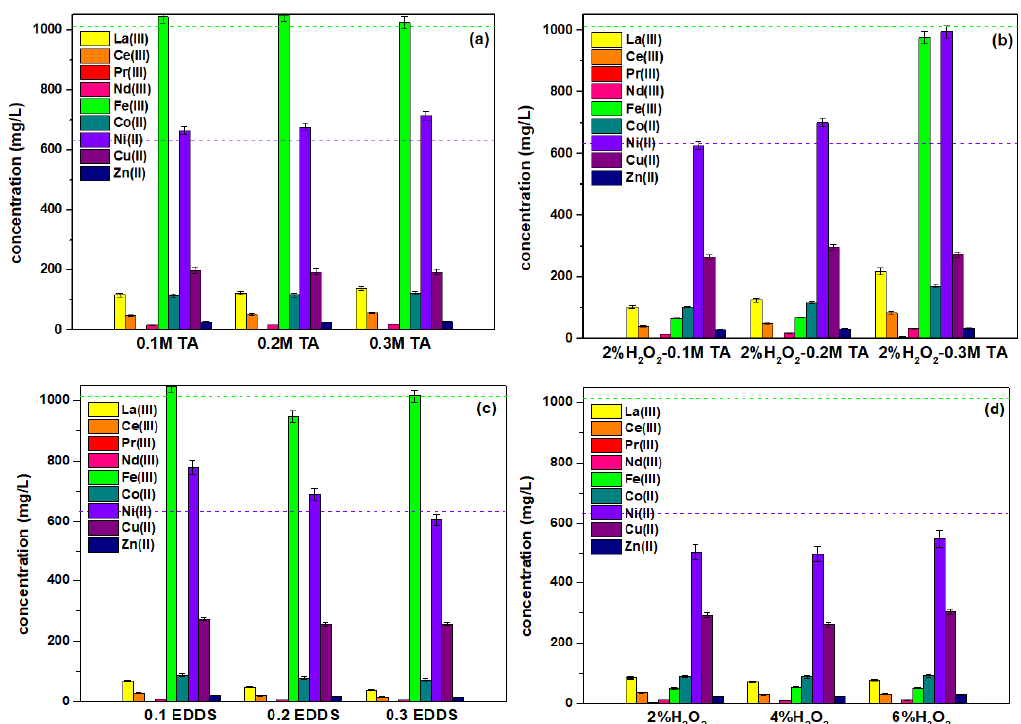
Figure 3. The concentration of La(III), Ce(III), Pr(III), Nd(III), Fe(III), Co(II), Ni(II), Cu(II), and Zn(II) in the PLS obtained from the black battery mass using 0.6 M CA with the additional amount of ( a ) TA, ( b ) H 2 O 2 and TA, ( c ) EDDS as well as ( d ) H 2 O 2 at 24 h. The green dash line represents the values of Fe(III) concentration and the purple one represents Ni(II) after H 2 SO 4 leaching under the same conditions.